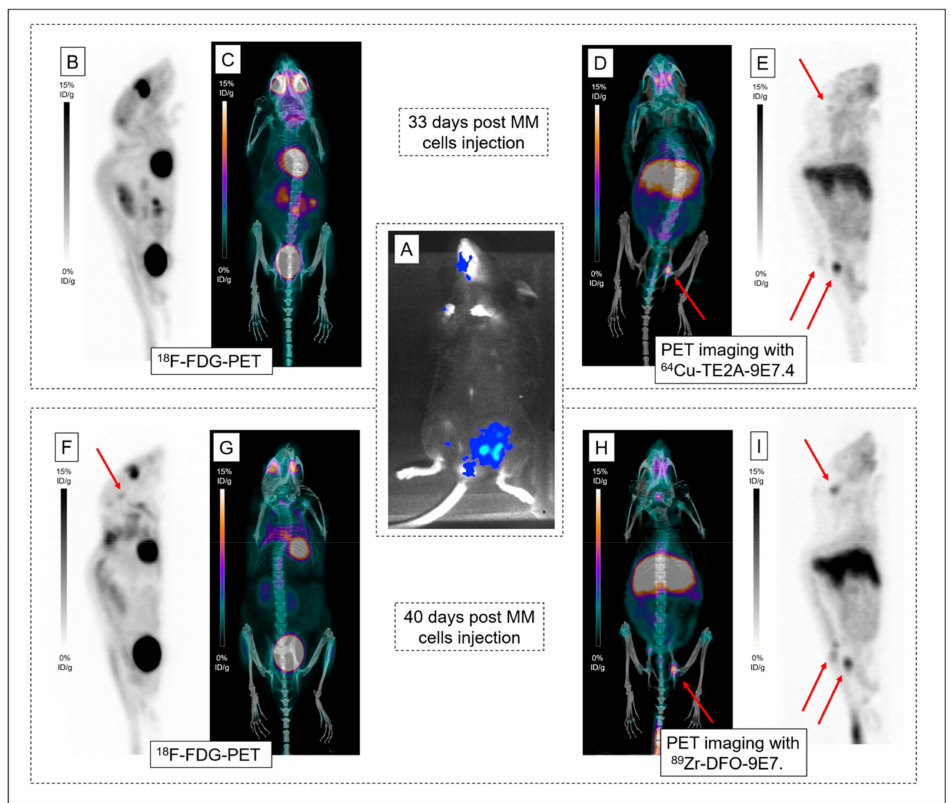
Figure 7. PET imaging with 64 Cu-TE2A-9E7.4 and 89 Zr-DFO-9E7.4. Bioluminescence imaging ( A ) revealing lesions in the spine and the left iliac wing. Maximum intensity projections of 18 F-FDG-PET and CT ( B ; C ) and maximum intensity projections of PET and CT imaging with 64 Cu-TE2A-9E7.4 at 24 h post-injection (PI) ( D ; E ), realized 33 days post multiple myeloma (MM) cells injection in Mouse 18. Maximum intensity projections of 18 F-FDG-PET and CT ( F ; G ) and maximum intensity projections of PET and CT imaging with 89 Zr-DFO-9E7.4 at 24 h (PI) ( H ; I ), realized 40 days post MM cells injection. Pathological uptakes were spotted by red arrows in the skull, spine and the left iliac wing.